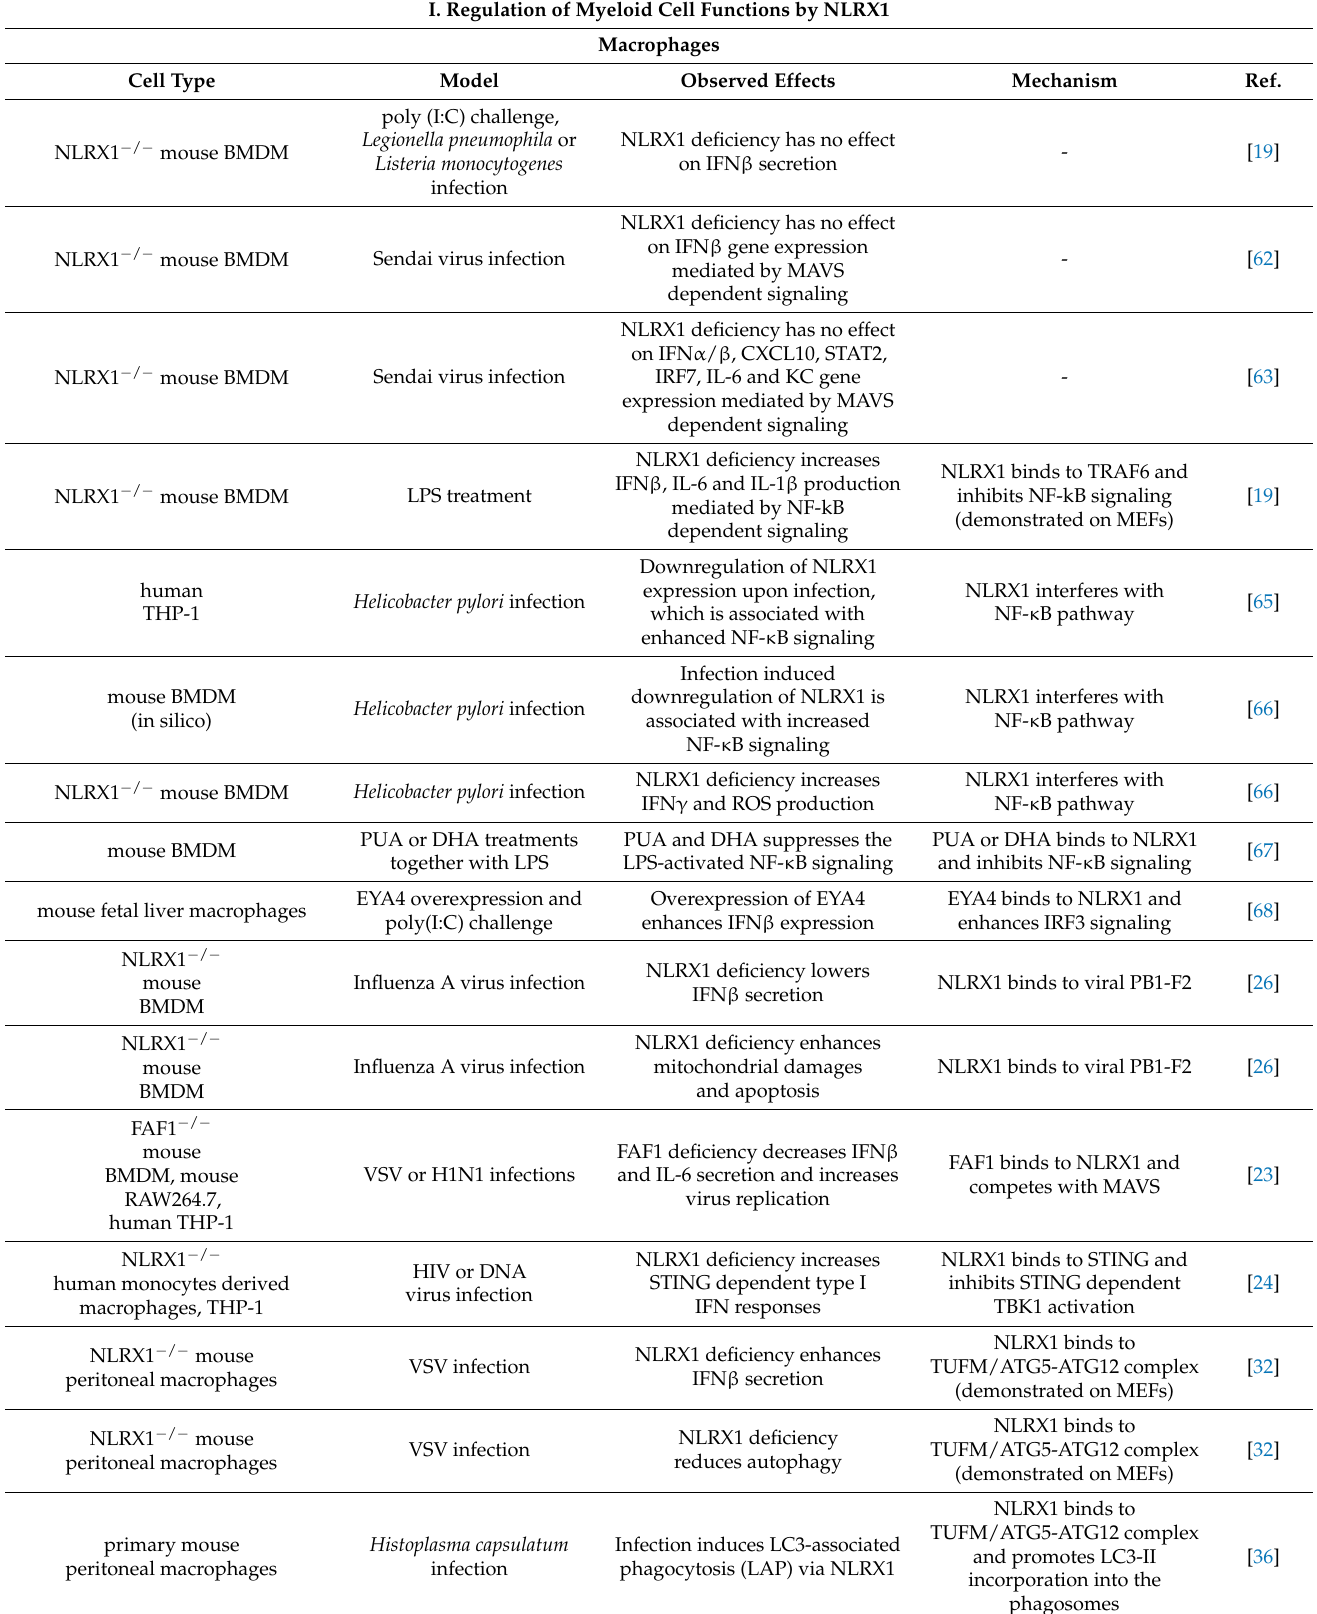
Table 1. Regulation of myeloid cell functions by